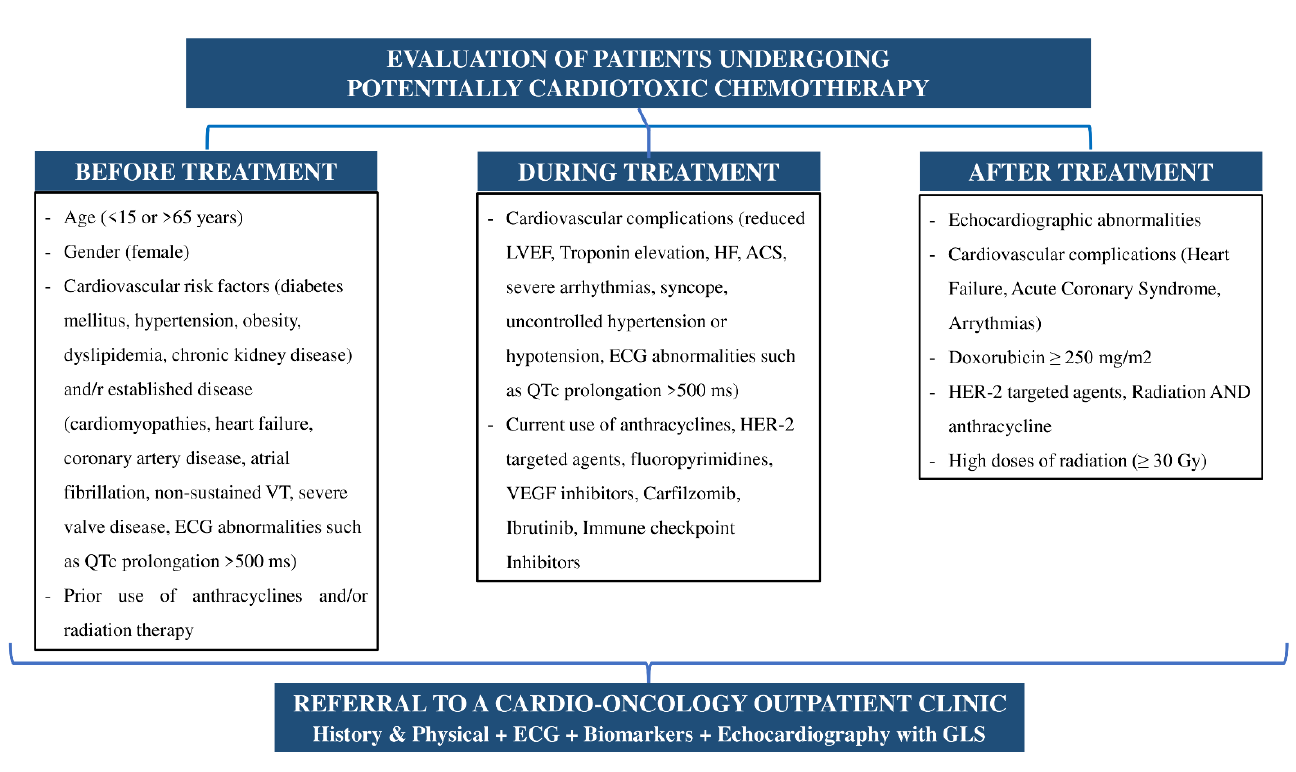
Figure 1. Suggested evaluation of patients with malignancies at risk for cardiotoxicity. (Figure 1 is an original figure, also including data from reference [21]).